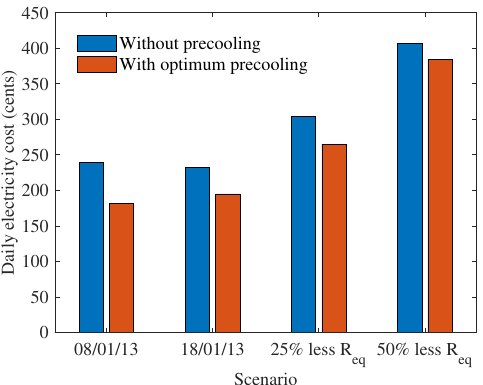
Figure 9. Electricity costs for house 165 for the different scenarios considered in the case